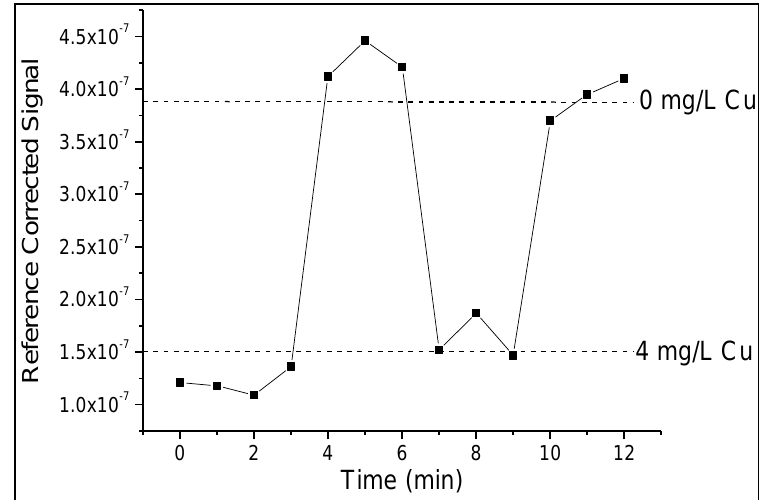
Figure 6. Rapid signal stabilization after changes in copper